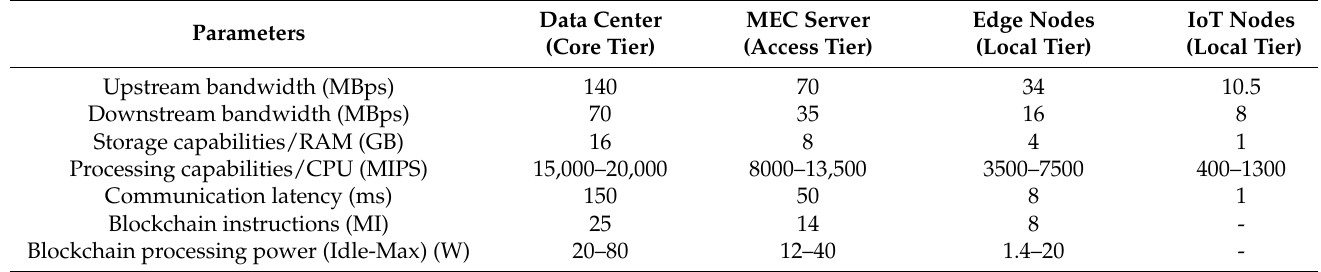
Table 1. Simulation parameters for the Health-BlockEdge framework. MI, millions of instructions.